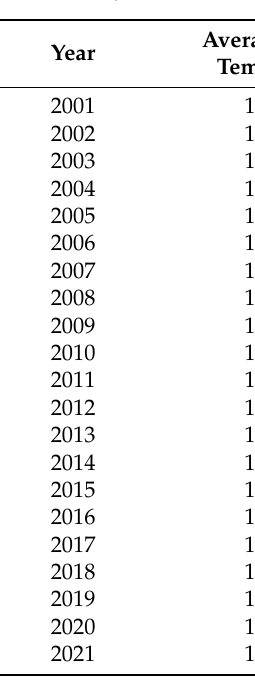
Table 9. Average maximum, minimum temperature and rainfall data of Murree and forest cover area. for the last 20 years